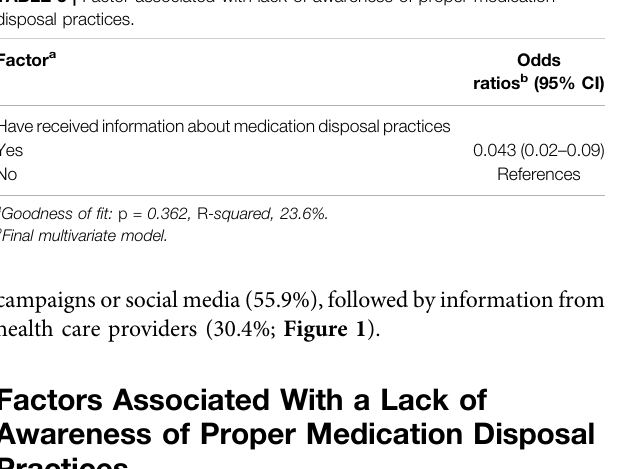
TABLE 3 | Factor associated with lack of awareness of proper medication disposal practices. Factor a Odds Havereceivedinformationaboutmedicationdisposalpractices